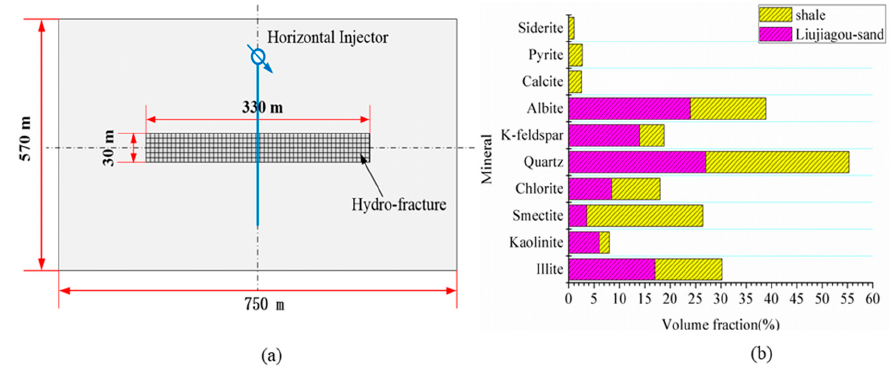
Figure 3. ( a ) Schematic of the computational model and ( b ) the mineral composition of the Yanchang (YC) shale and Liujiagou (LJG) sand.